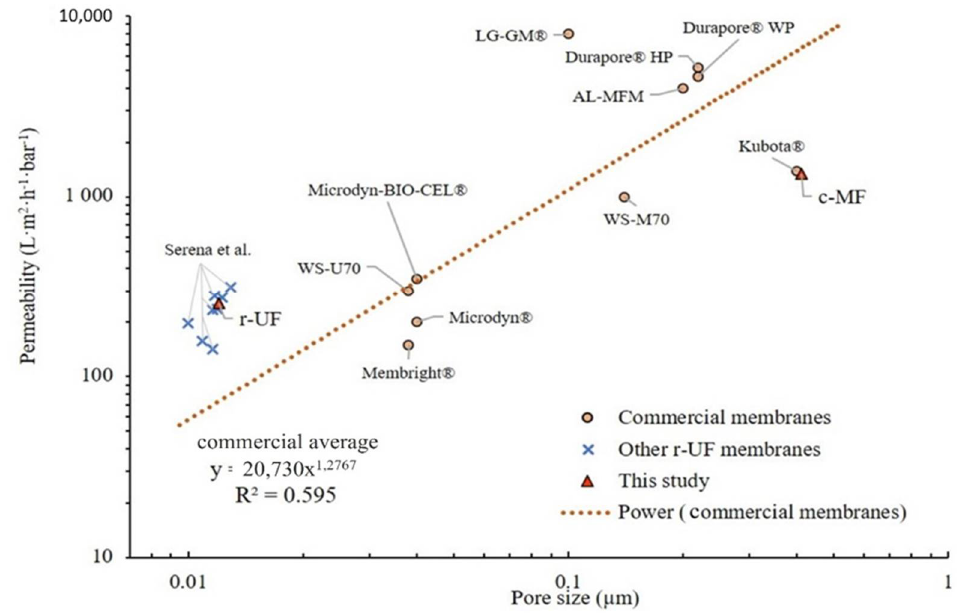
Figure 4. Membrane permeability for clean water according to pore size for commercial membranes and the membrane used in the present study according to Judd et al. and Molina et al. [15,26]. The obtained permeability (L; L·m −2 ·h −1 ·bar −1 ) for the r-UF membrane was 255 ± 4 L·m −2 ·h −1 ·bar −1 . This permeability value is in accordance with the average permeability range of various UF commercial membranes (i.e., 200−300 L·m −2 ·h −1 ·bar −1 ) (Figure 3). Fur-